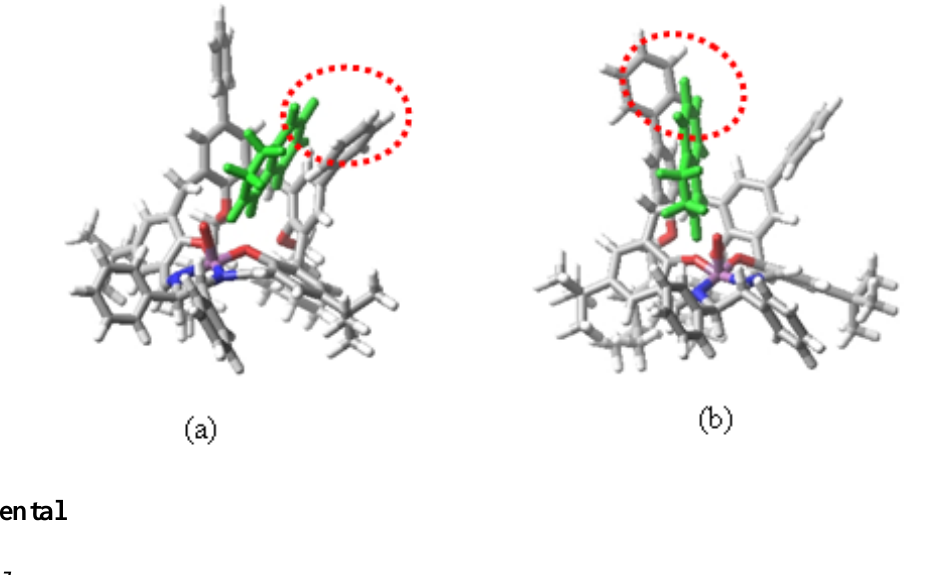
Figure 4. Computer optimized structures concerning the re ( a ) and si ( b ) face attack of dihydronaphthalene to the 6-Mn